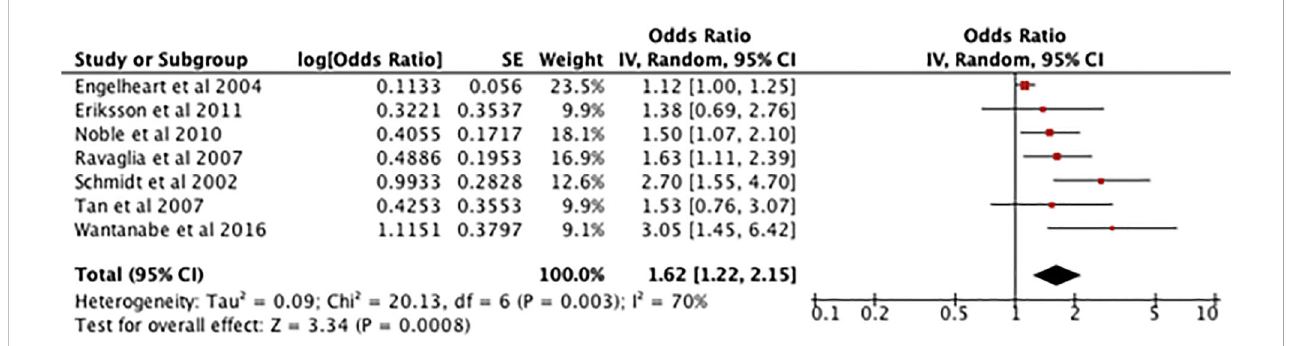
FIGURE 6 Forest plot showing the results of a meta-analysis investigating the relationship between midlife raised CRP serum levels and dementia. A positive odds ratio value indicates that dementia is more prevalent in participants who have had raised serum CRP and the P value shows its statistical signi fi cance (15 –